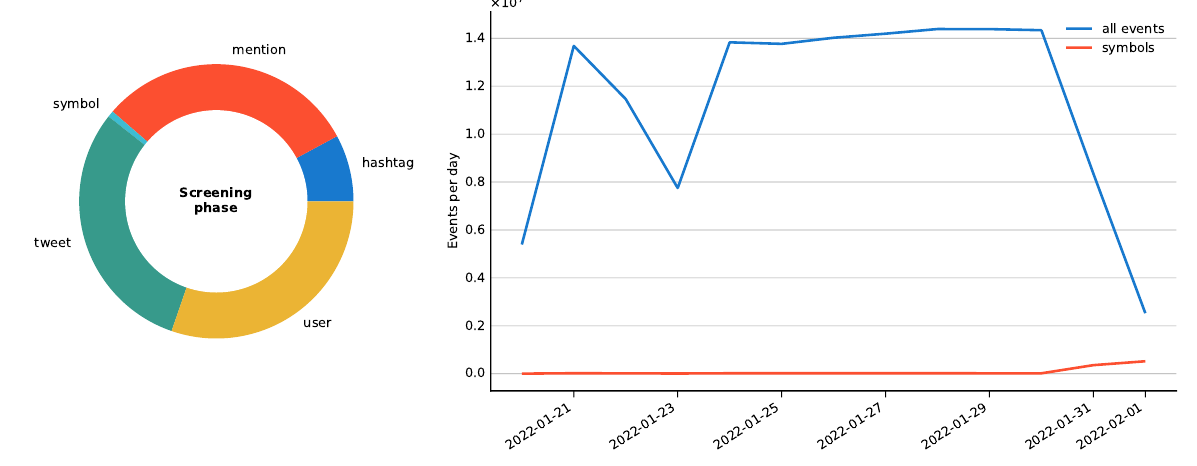
Figure 7. Recorded events (screening phase of use case